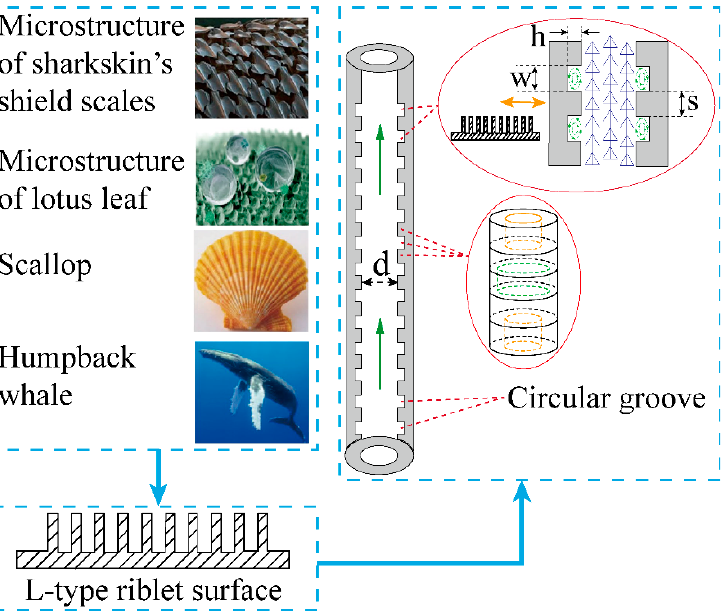
Figure 2. Concept diagram of a BCT (note: d is the diameter (m), h is the groove depth (m), w is the groove width (m), and s is the slot pitch (m).